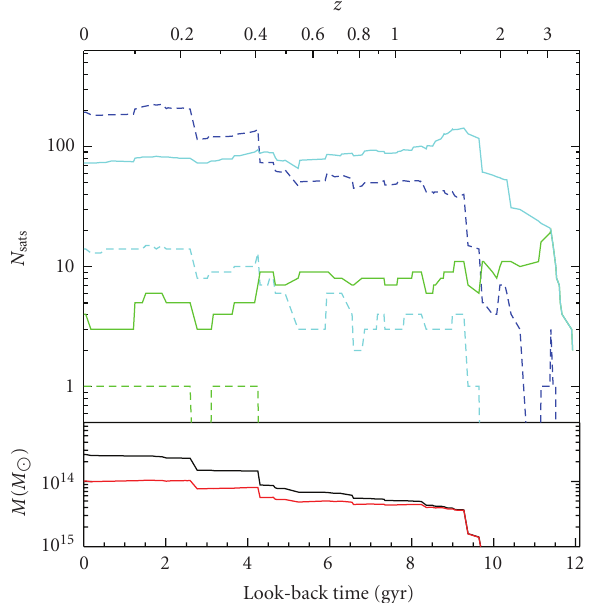
Figure 4: The di ff erential mass function of subhalos for systems with di ff erent ranges of formation epoch: z 50 = 0 − 0 . 25 (blue), z 50 = 0 . 25 − 0 . 45 (green), z 50 = 0 . 45 − 0 . 65 (yellow), and z 50 > 0 . 65 (red). panel shows how the total mass of the main halo (upper, black line) and the mass within the central 390 kpc build up with time. The upper panel shows how the number of satellites changes with time. The dashed curves are for satellites with masses in excess of 10 11 M (cid:2) , 10 12 M (cid:2) , and 10 13 M (cid:2) , respectively, from top to bottom. The solid curves are for satellites with masses of more than 0.1% or 1% of the main system’s mass, respectively, from top to bottom.